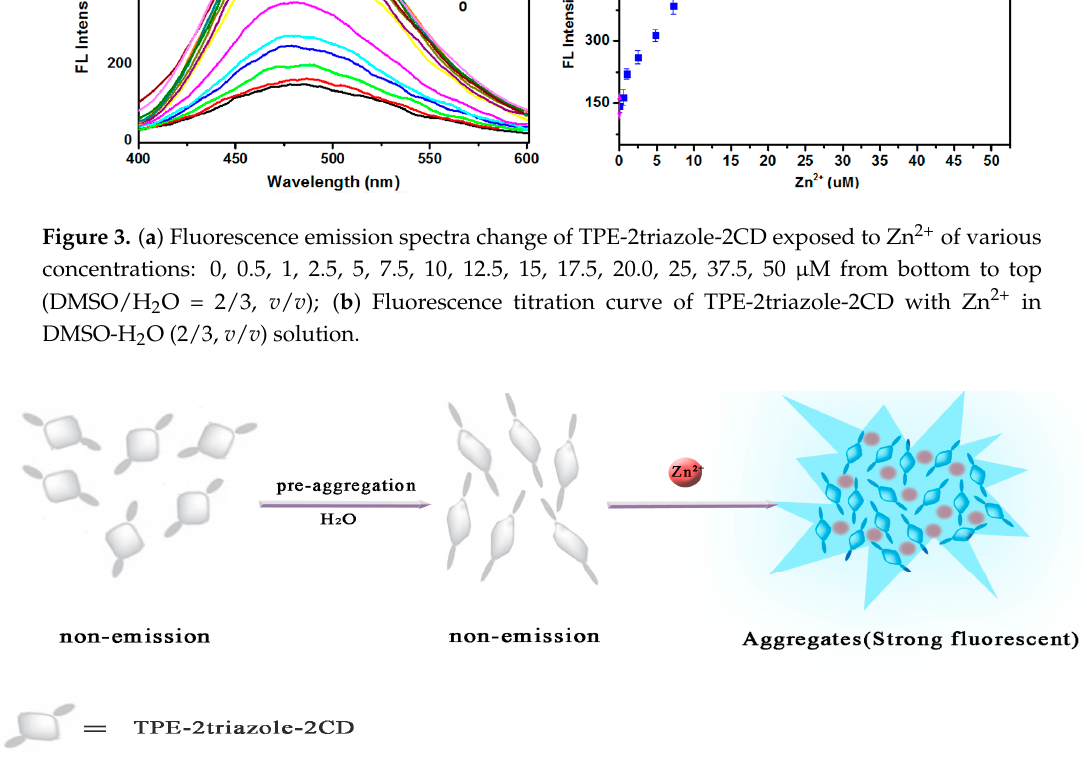
Figure 4. Possible proposed mechanistic pathway for sensing Zn 2+ ion-based on Aggregation Induced Emission.